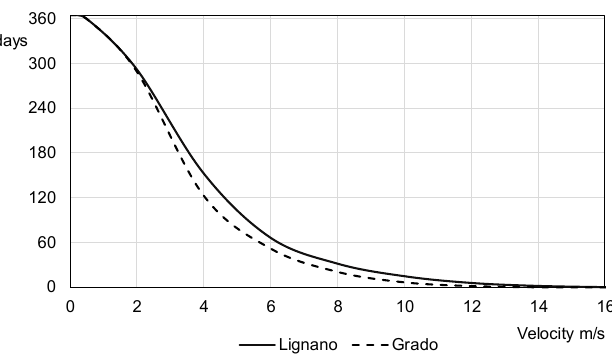
Figure 7. Wind velocity duration curves of Lignano e Grado. Table 2. Identification of wind classes: representative speeds and respective durations calculated over 1 year. The last four columns represent the subdivision in percentage of days for the main chosen directions.